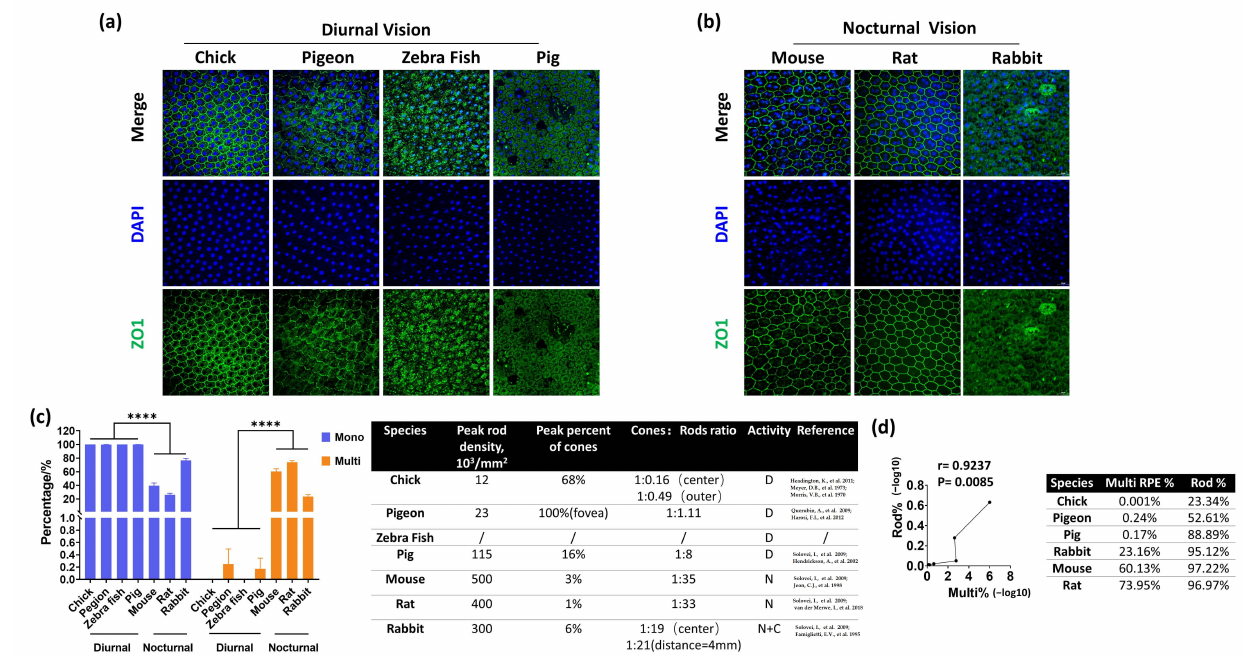
Figure 2. High percentage of multinucleated RPE correlates with nocturnal vision. RPE cells in